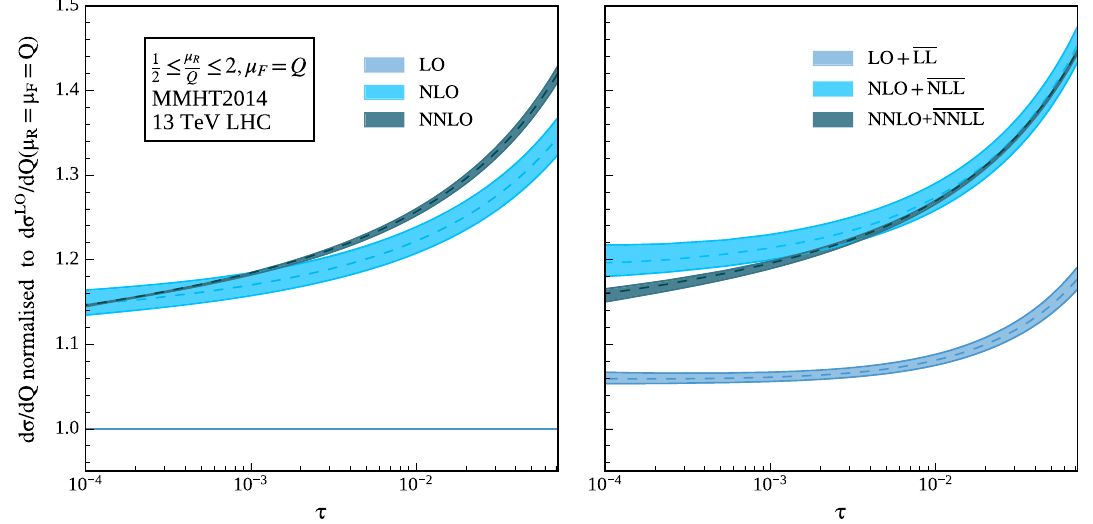
Fig. 7 μ R scale variation of the resummed results against the fixed-order with the scale μ F held fixed at Q for 13 TeV